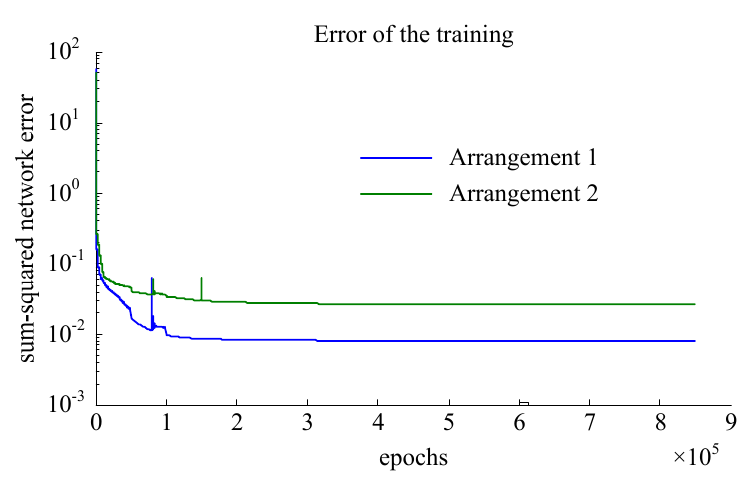
Figure 8. Neural network training